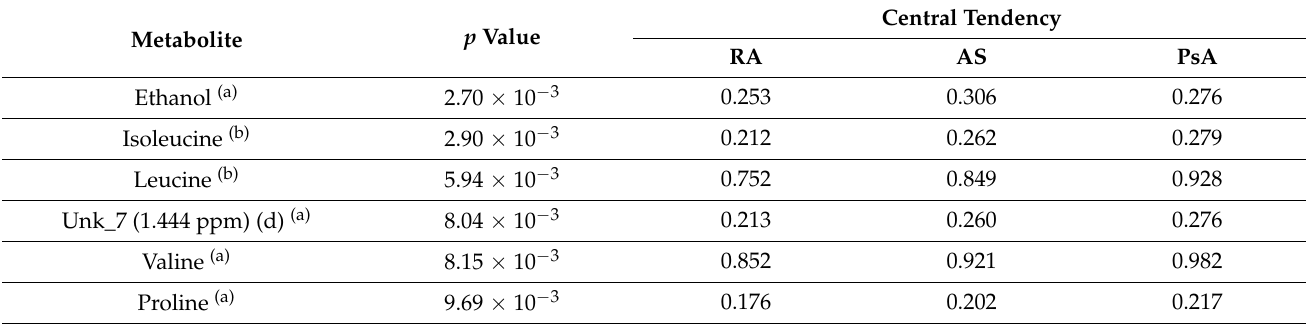
Table 5. Summary of univariate analysis for RA, AS, PsA comparison at the BT time point.